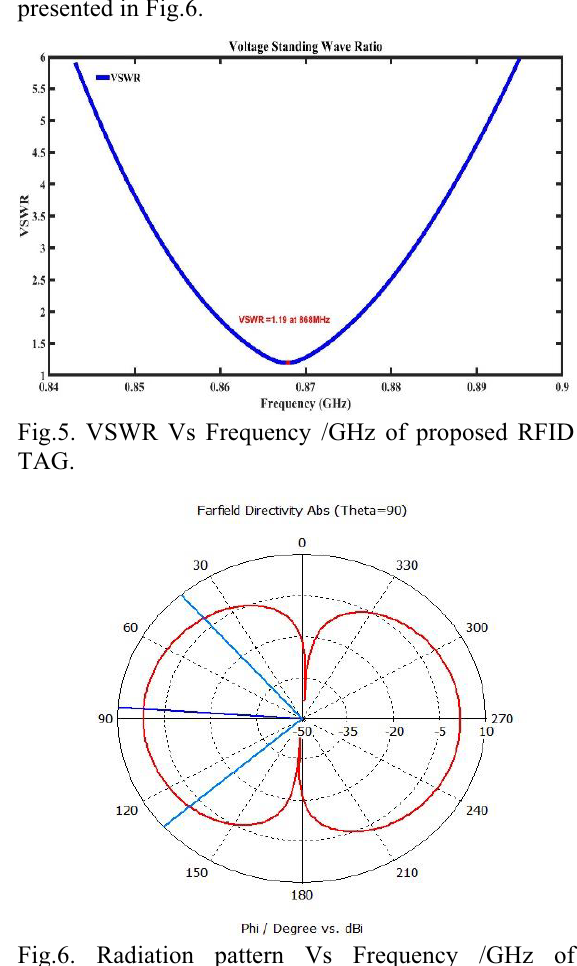
Fig.6. Radiation pattern Vs Frequency /GHz of proposed RFID TAG.